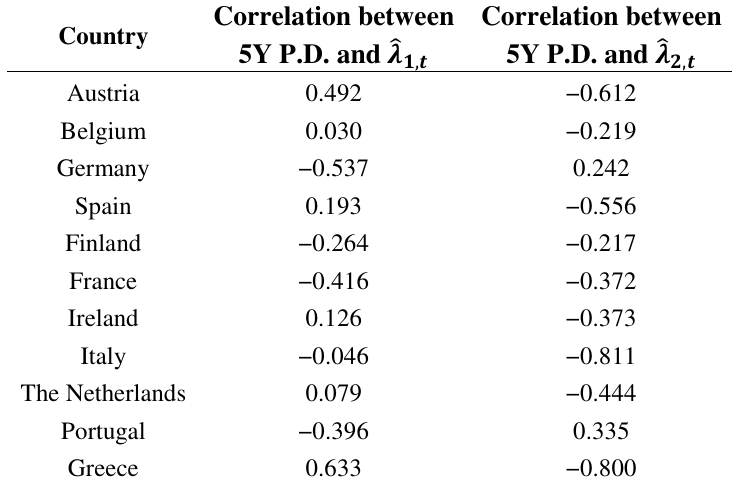
Table 7. Correlation between time variant speed adjustment parameters and 5 year default